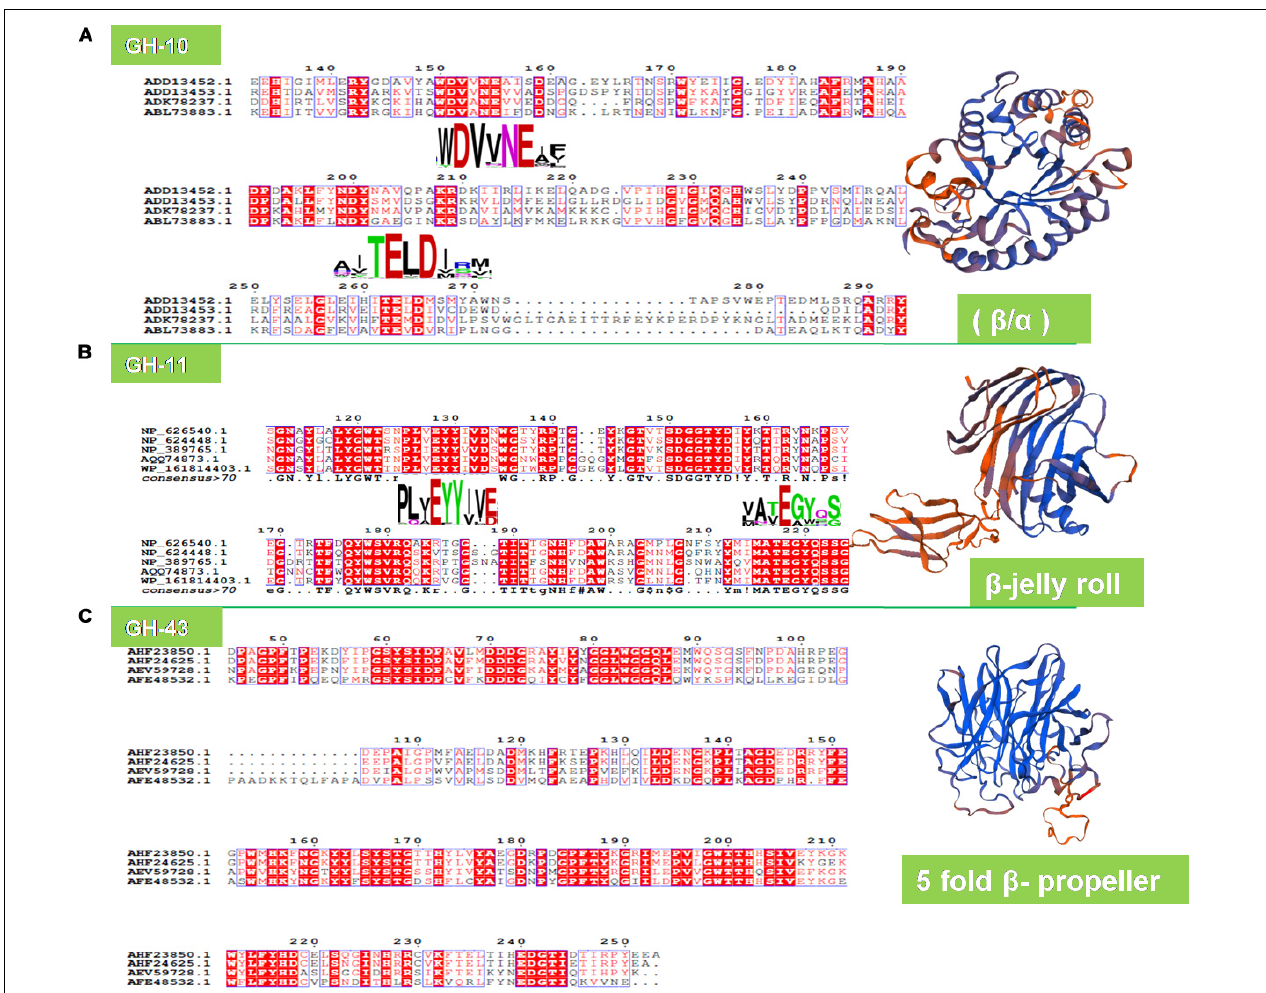
FIGURE 3 | Structure analysis of metagenomic xylanolytic enzymes. The ESPRipt analysis showing the conserved motifs for (A) GH-10 (WDVVNEI/A and TEL/MDM/I), (B) GH-11 (PLY/AEYYI/VE/D and ATEGYQ) endoxylanases, and (C) GH-43 (DDDG and LFYI). The GH-10 and GH-11 xylanases exhibited conserved motifs having highly conserved catalytic glutamate (E) and aspartate (D) residues. The signature structure of metagenomic GH-10 (Accession number: ADK78237.1), GH-11 (accession number: AQQ74873.1), and GH-43 (accession number: AFE48532.1) enzymes.